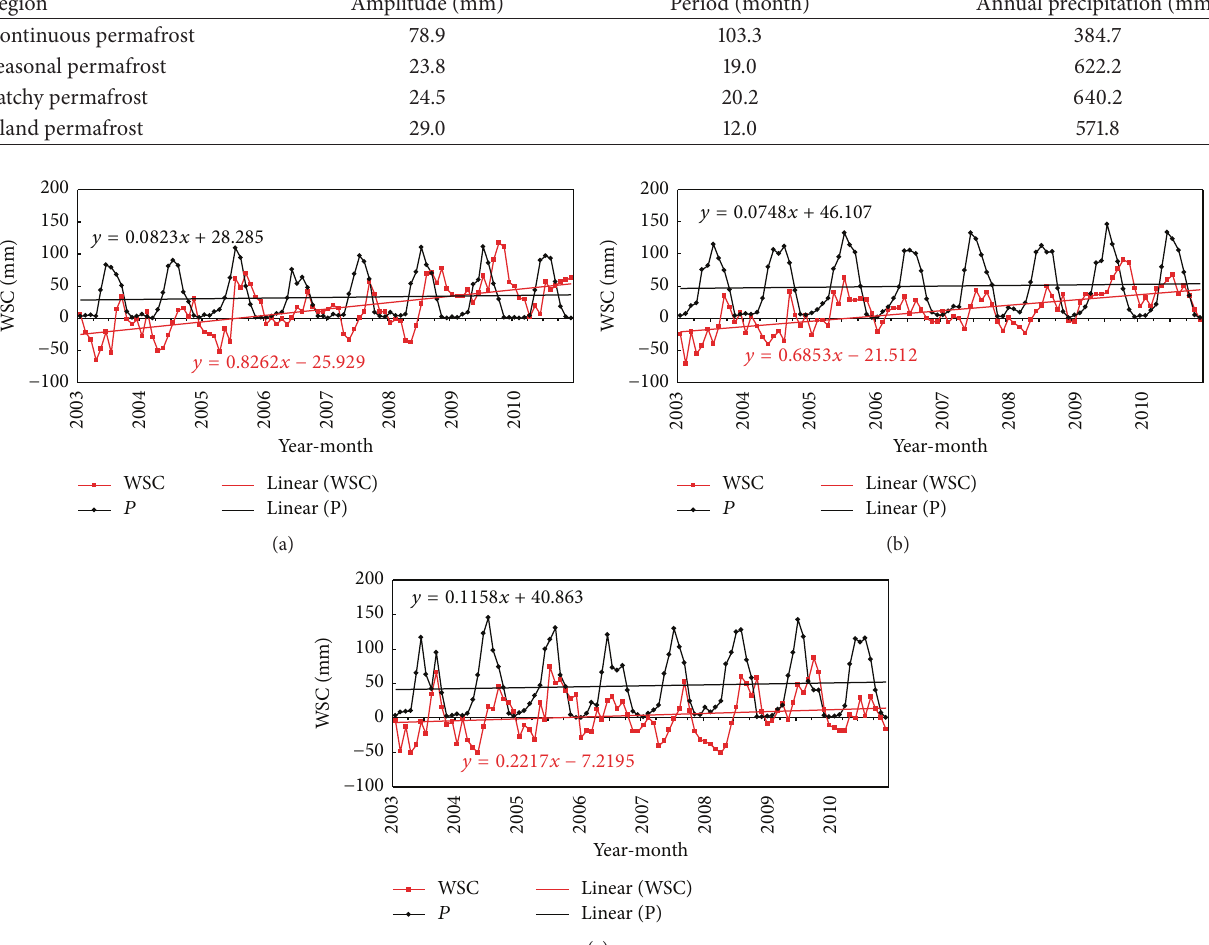
of WSC was greatest in the source region of the Yangtze River and lowest in the source region of the Lancang